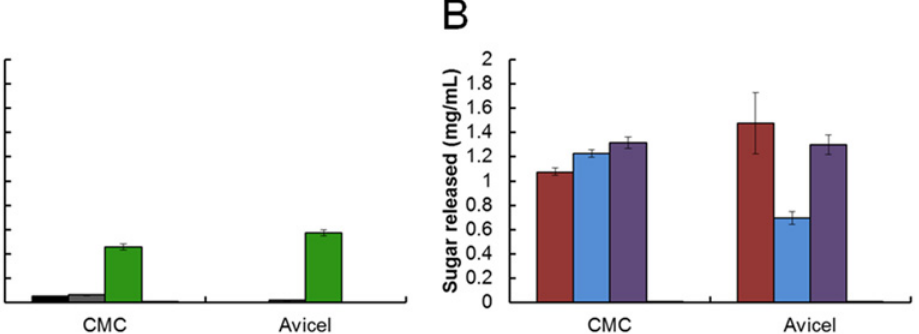
Fig 3. Enzymatic activity of full-length CelA produced intra- and extracellularly. Substrates used as sole carbon source were carboxymethylcellulose (CMC) and Avicel. A) Activity of intracellular (400 μ g/mL CFE) protein fractions from the wild type JWCB001 (black), JWCB005 Δ pyrFA (grey), and JWCB040 Δ pyrFA pDCW170:: celA (no signal sequence) (green). B) Culture supernatant (25 μ g/mL of concentrated protein) from JWCB018 Δ pyrFA ldh :: ISCbe4 Δ cbe1 (red), JWCB029 Δ pyrFA ldh :: ISCbe4 Δ cbe1 Δ celA (blue), and JWCB046 Δ pyrFA ldh :: ISCbe4 Δ cbe1 Δ celA pDCW173:: celA (with the signal sequence) (purple).